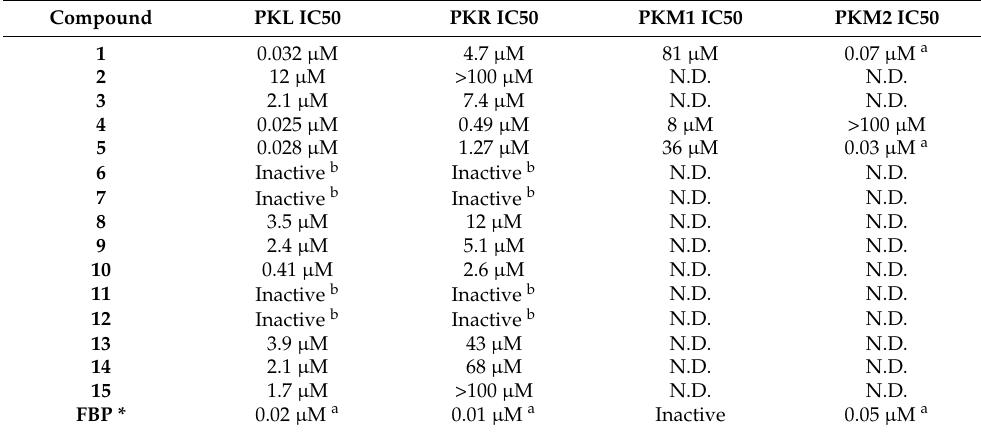
Table 1. In vitro Pyruvate Kinase